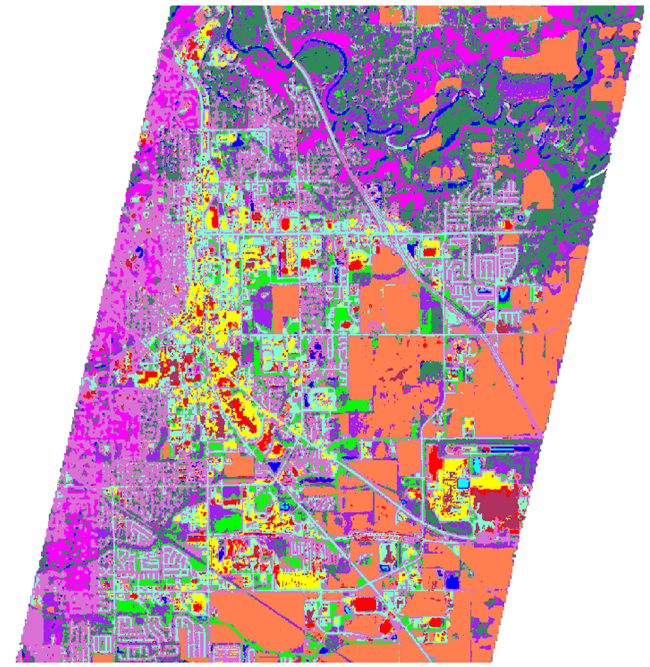
Figure 14. The classification map of Hyperion-Sentinel fusion result by Two-CNN-Fu method, the classifier is CCF.